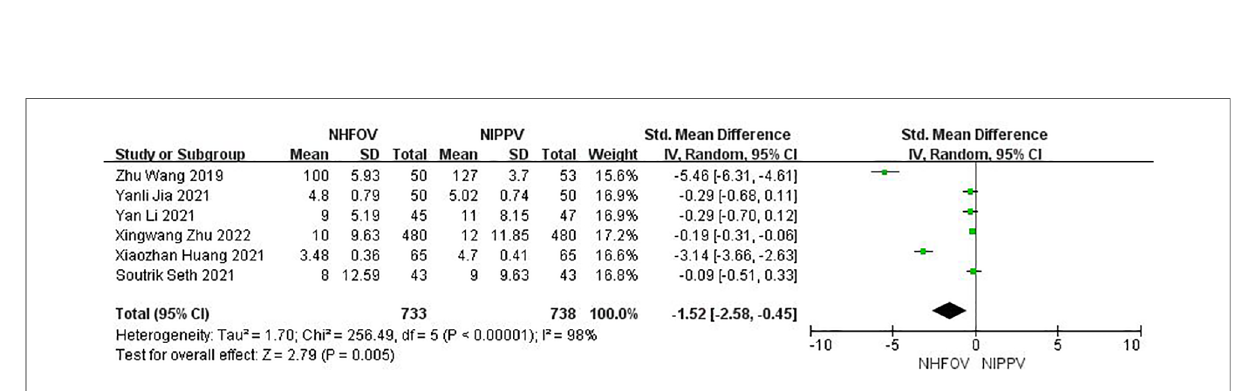
FIGURE 4 Results of the meta-analysis of duration of non-invasive ventilation.